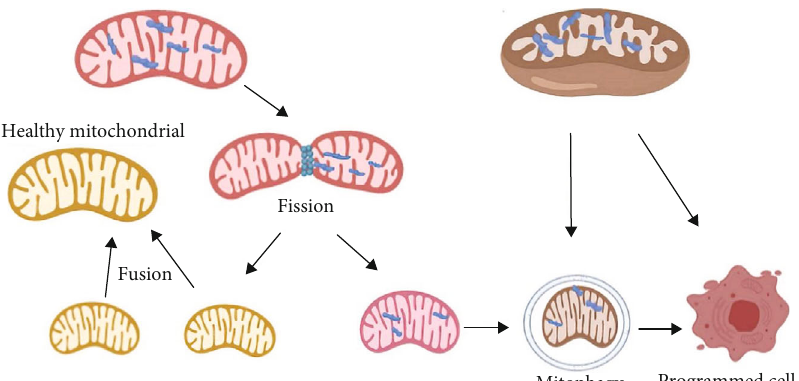
Figure 1: Role of mitochondrial damage in programmed cell death and preventive function of fusion, fi ssion, and mitophagy. A partially altered mitochondrion (with blue blot) undergoes mitochondrial fi ssion, leading to impaired mitochondria and a healthy small partner (without blue blot). The impaired components of mitochondria are eliminated through mitophagy. The two small healthy mitochondria generated undergo mitochondrial fusion to attenuate mitochondrial stress and restore mitochondrial function. However, when damage accumulates, a severely damaged whole mitochondrion is removed by mitophagy, and when the damage reaches a critical level, mitochondria will initiate programmed cell